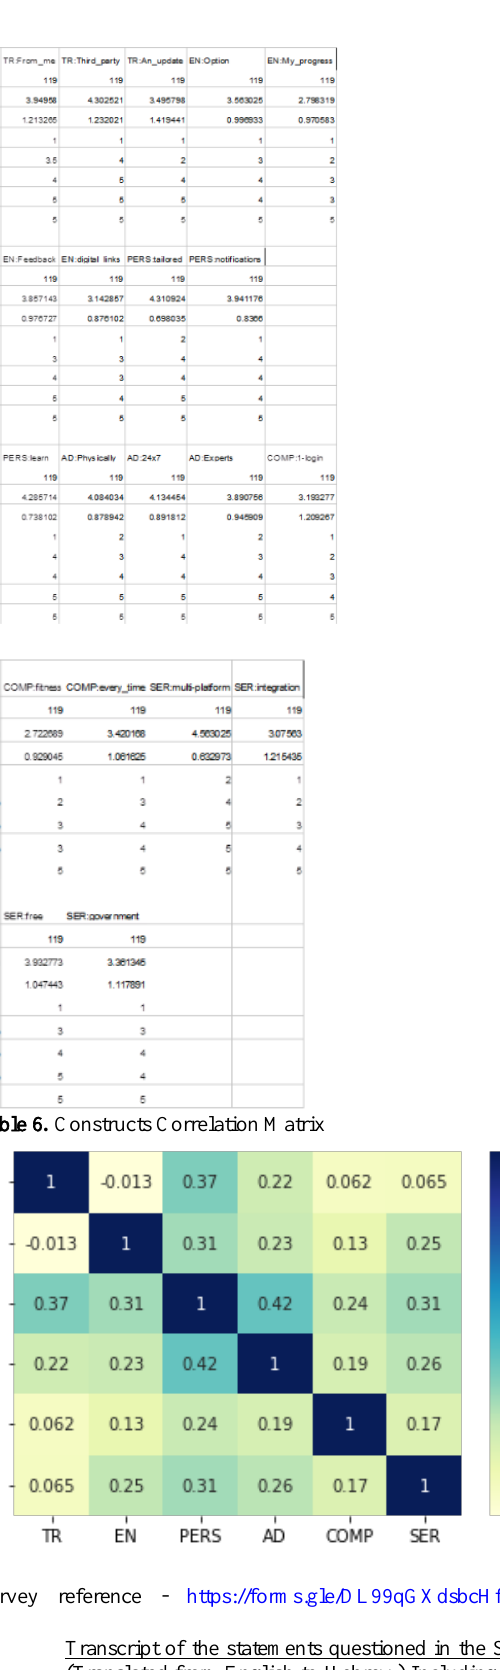
Table 5 . Full standalone variable analysis